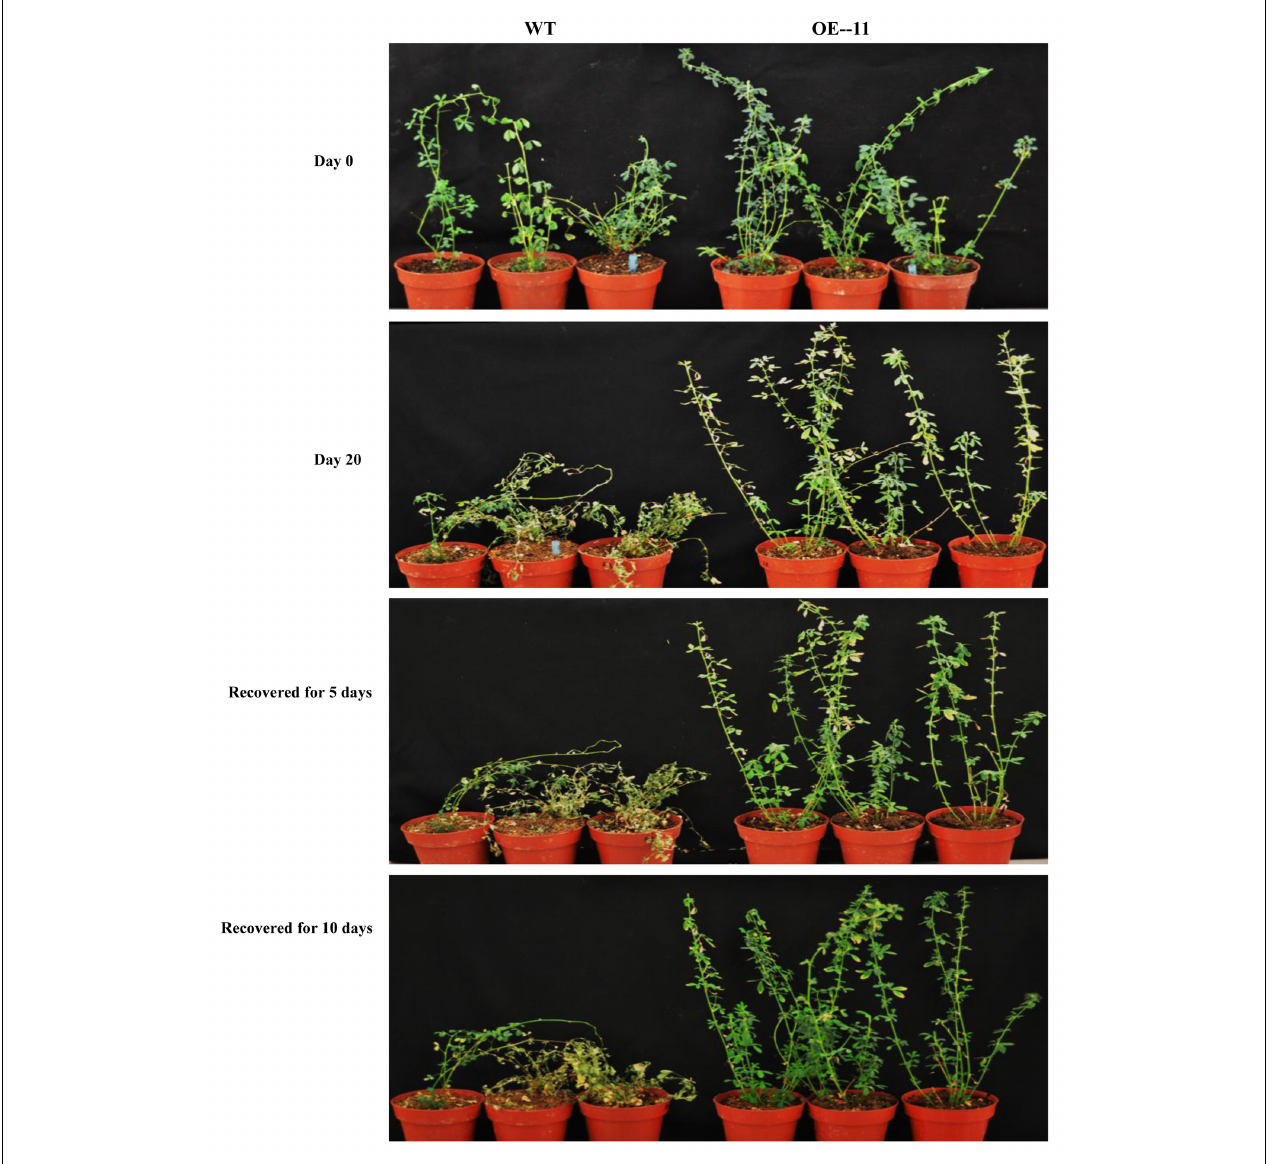
FIGURE 2 | Growth performance of the AtEDT1 transgenic alfalfa under normal and drought stress conditions. Day 0: wild type and transgenic alfalfa lines without any drought stress; Day 20: 20 days after drought stress treatment; Recovered for 5 days: recovered for 5 days after 20-day drought treatment; Recovered for 10 days: recovering for 10 days after 20-day drought